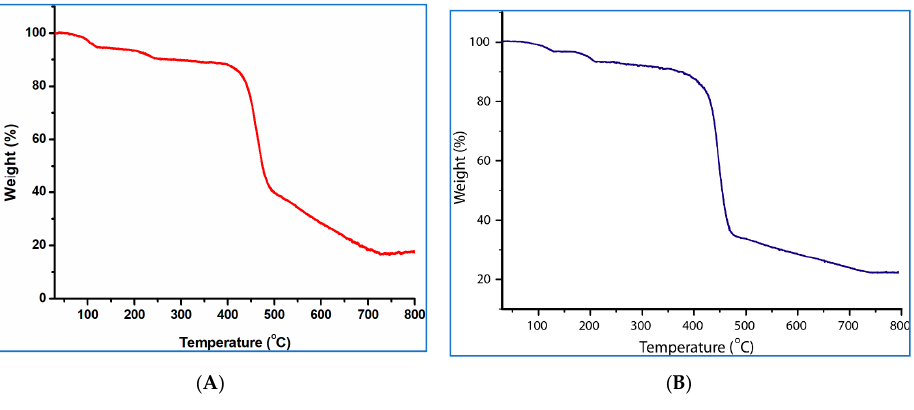
Figure 2. Thermogravimetric curves for 1 ( A ) and 2 ( B ).